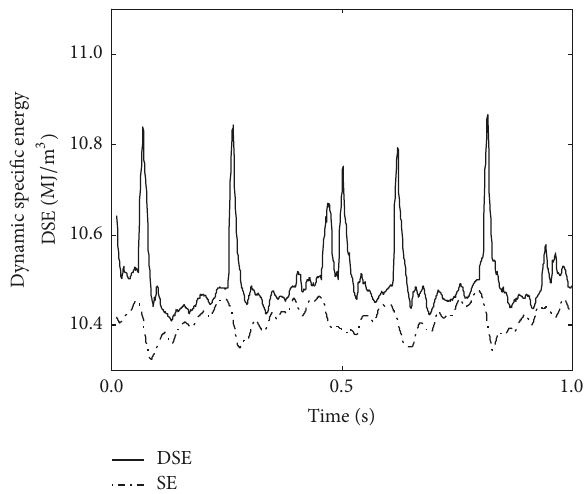
Figure 6: DSE in soft rock tunneling for Ω 0 = 6 rpm and 𝑉 0 = 1.2 mm/s.